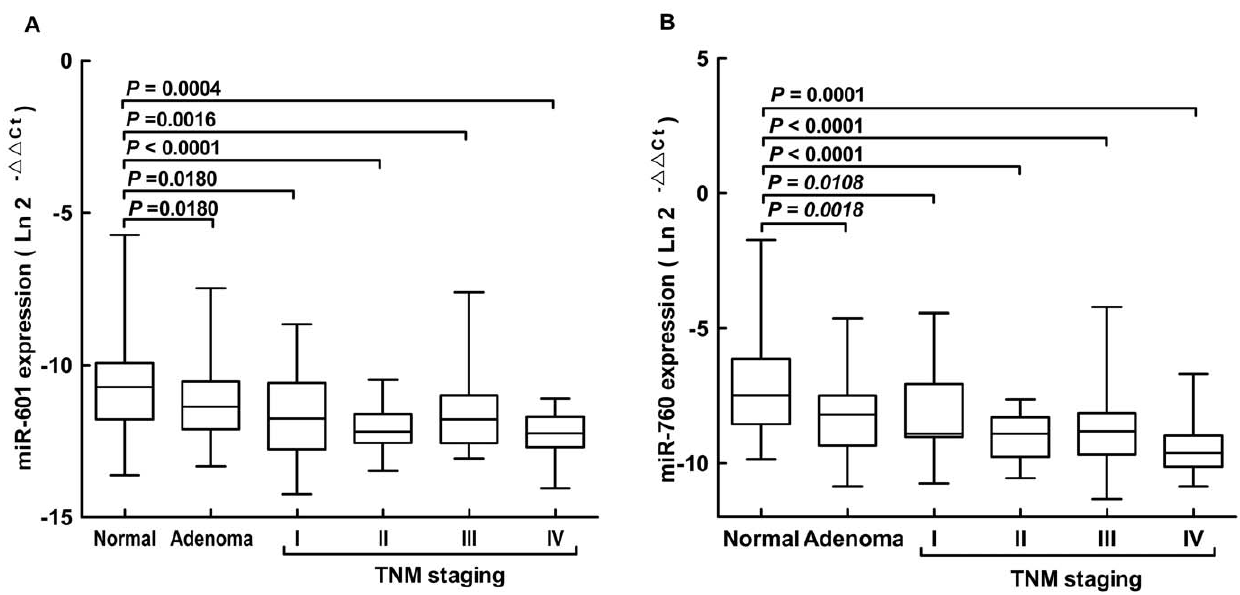
Figure 3. Association of plasma miR-601 and miR-760 expression with different TNM stages. Box plots of plasma levels of miR-601(A) and miR-760(B) in normal subjects (n=58), advanced adenomas(n=43) and CRC patients(n=90) with different TNM stage (26 with I, 25 with II, 29 with III and 10 with IV). Expression levels of the miRNAs are normalized to cel-miR-39. The lines inside the boxes denote the medians. Mann-Whitney U test was used to determine statistical significance.